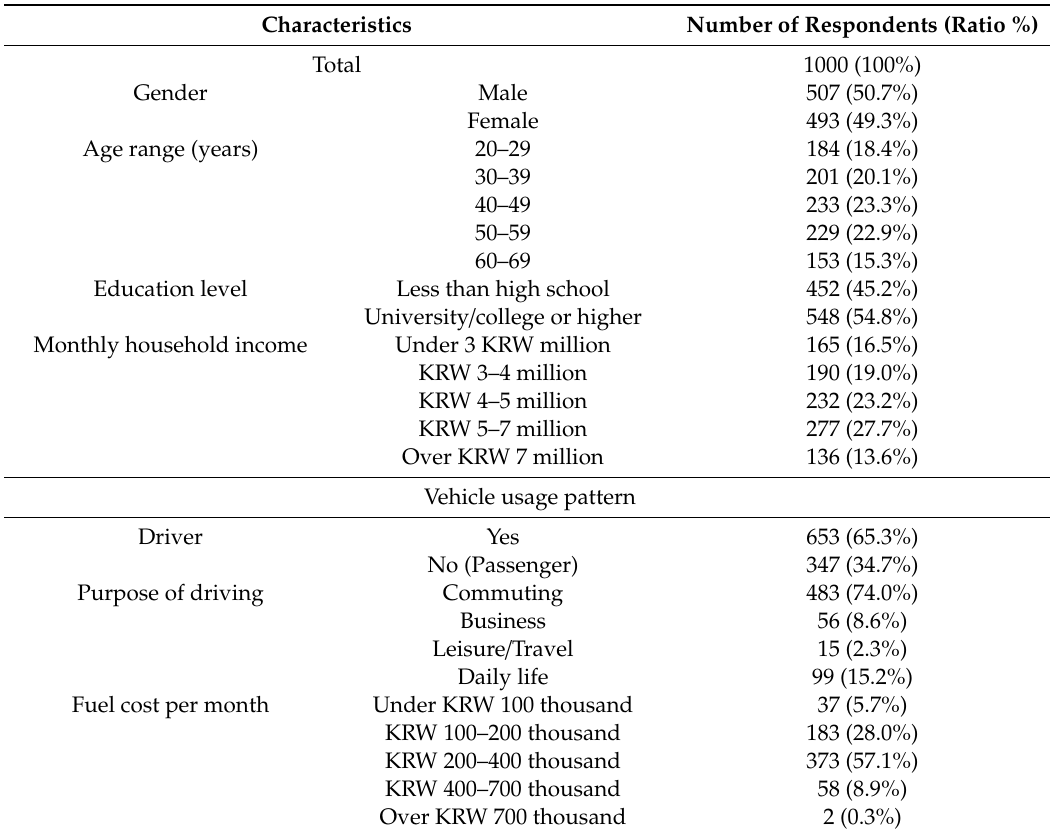
Table 3. Descriptive statistics of the